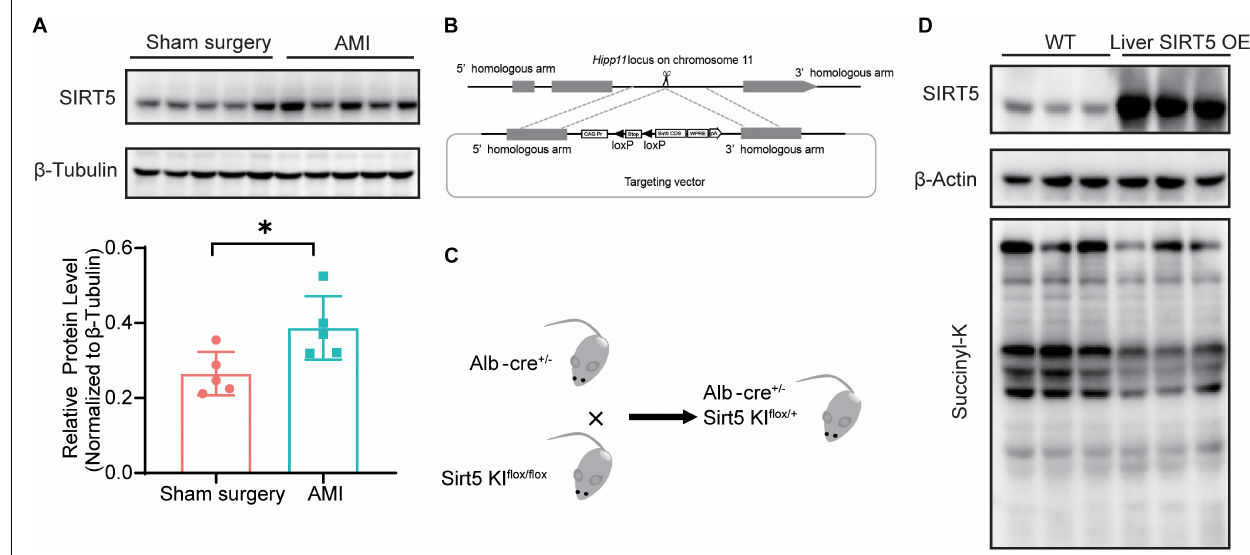
FIGURE 1 | SIRT5 is up-regulated in the liver of experimental myocardial infarction mice. (A) Western blot analysis of hepatic SIRT5 in C57BL/6J mice 5 days after sham surgery or experimental myocardial infarction (AMI) ( n = 5). Expression levels of SIRT5 were normalized to β -tubulin ( n = 5). ∗ p < 0.05 comparing with sham surgery. (B) Strategy of an alternative SIRT5 allele knock-in by CRISPR/Cas9 method. (C) Schematic diagram for breeding strategy to generate Liver SIRT5 OE mice. (D) Western blot analysis of SIRT5 and protein succinylation in the liver of WT mice and Liver SIRT5 OE mice ( n =